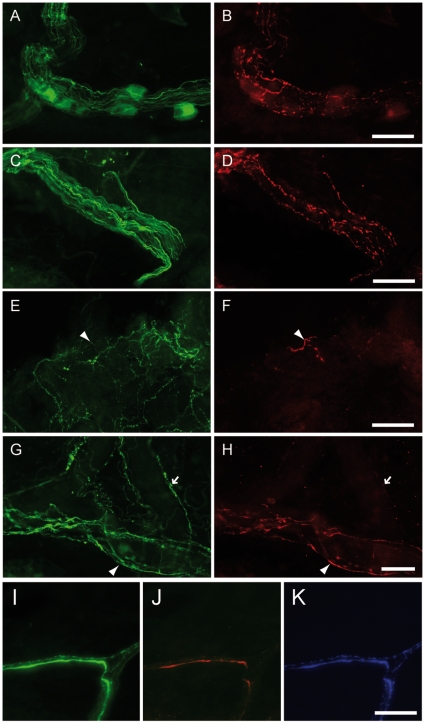
Phospho-α-synuclein-positive submucosal neurites in PD patients.Labeling with antibodies against neurofilament (NF) (ACEGI) and phosphorylated α-synuclein (BDFHJ) revealed that some NF-immunoreactive (IR) neurites were also phospho-α-synuclein-IR. Occasionally, these phospho-α-synuclein-IR neurites were present amidst a submucosal ganglion (AB). Some of these structures formed bundles (D) while others were isolated (arrowhead in F). Thirty seven percents of the phospho-α-synuclein-IR neurites were perivascular (GH). Triple immunostaining with antibodies against tyrosine hydroxylase (K) revealed that 60% of LN were also TH-immunoreactive (IJK). Scale bar: 30 µm.